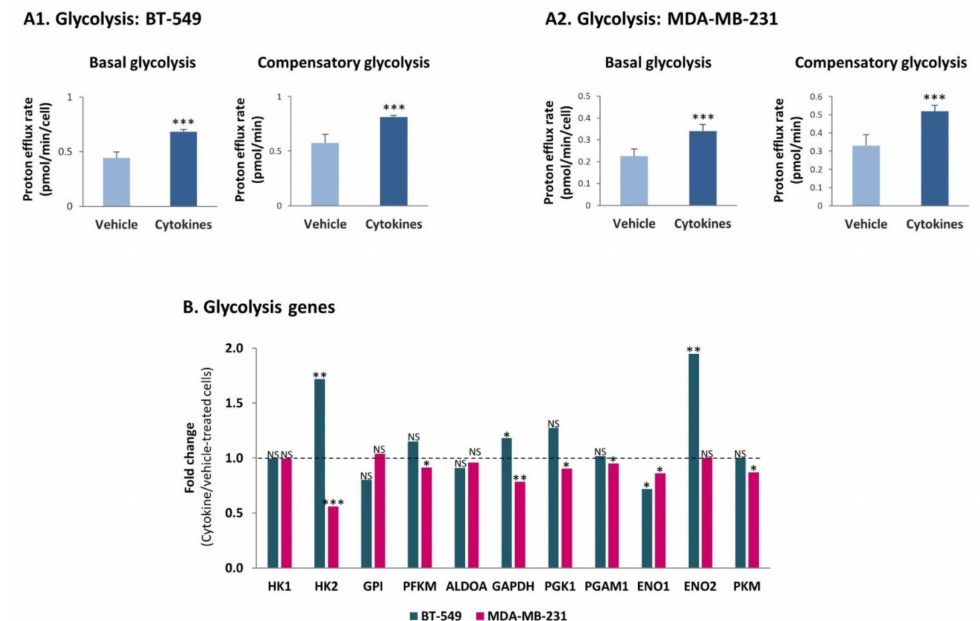
Figure 7. Continuous TNF α + IL-1 β stimulation increases the glycolytic activity of TNBC cells, in a transcription independent manner. ( A ) Glycolytic activity. BT-549 and MDA-MB-231 cells were continuously stimulated by TNF α + IL-1 β , or treated by a vehicle control (as described in Figure 1), and the glycolytic activities were determined by the seahorse technology. ( A1 ) BT-549 cells. ( A2 ) MDA-MB-231 cells. The results of a representative experiment of n = 3 are presented. *** p < 0.001. ( B ) Fold change in expression of genes coding for glycolysis enzymes, between cytokine-stimulated and vehicle-treated cells, determined by the transcriptome analyses (described in Figure 2). *** p < 0.001, ** p < 0.01, * p < 0.05. NS, Not